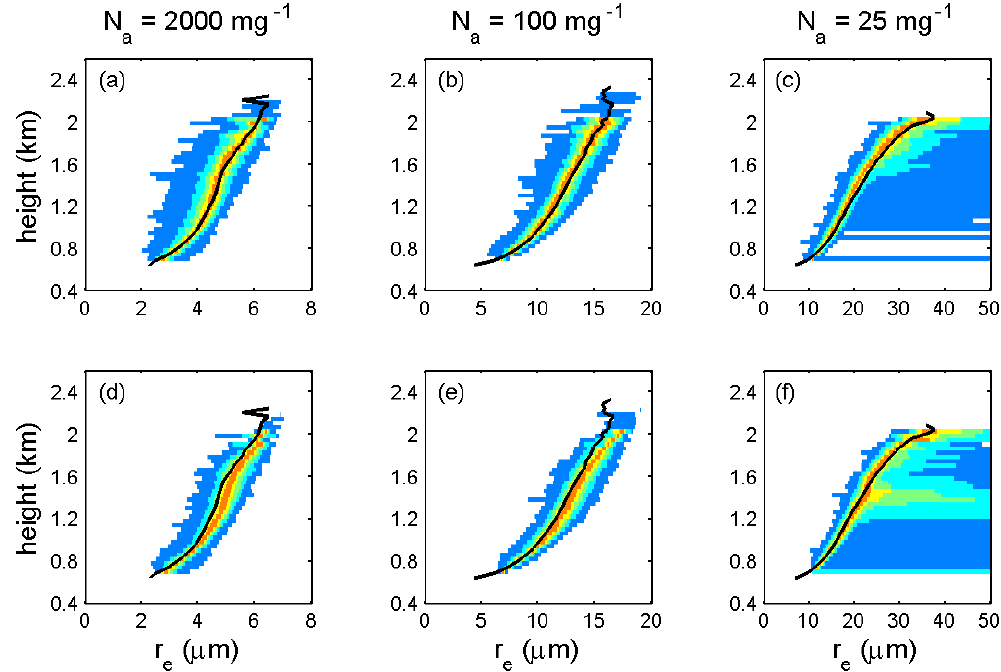
Fig. 2. Constructed r e profiles using different measures of cloud-top r e . (a, b, c) Using r e at one grid point below the highest grid that has q l > 0 . 01gkg − 1 . (d, e, f) Using maximum r e in the column. Color scale is the same as Fig. 1. The 50th percentile of the r e from all cloud samples in each case are shown for reference (black lines, same as Fig.